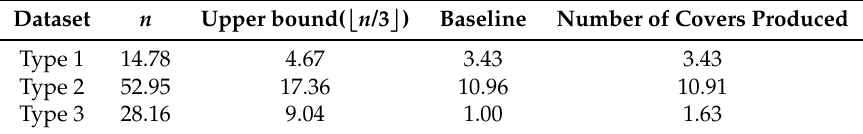
Table 6. Experiments on the minimum cover with a visibility constraint.